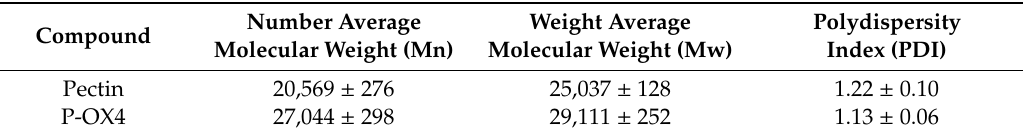
Table 1. Average molecular weight data for P-OX4 derivatives, as determined by gel permeation chromatography (GPC) ( n = 3, ± SD).